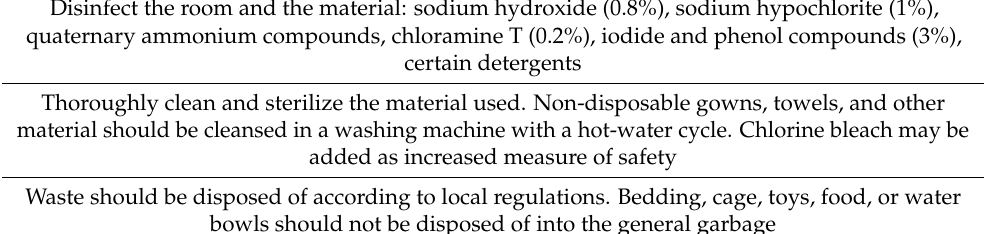
Table 2. Measures to be observed by veterinarians when a patient with monkeypox is suspected. The visit should be planned so that it does not coincide with other clients and to be able to thoroughly disinfect. The suspected case should be the last one of the day. clinic, nor should it be taken to a common treatment room. The number of staff allowed in the exam room and that come in contact with the suspected animal should be limited to as few persons as possible Record all data to optimize